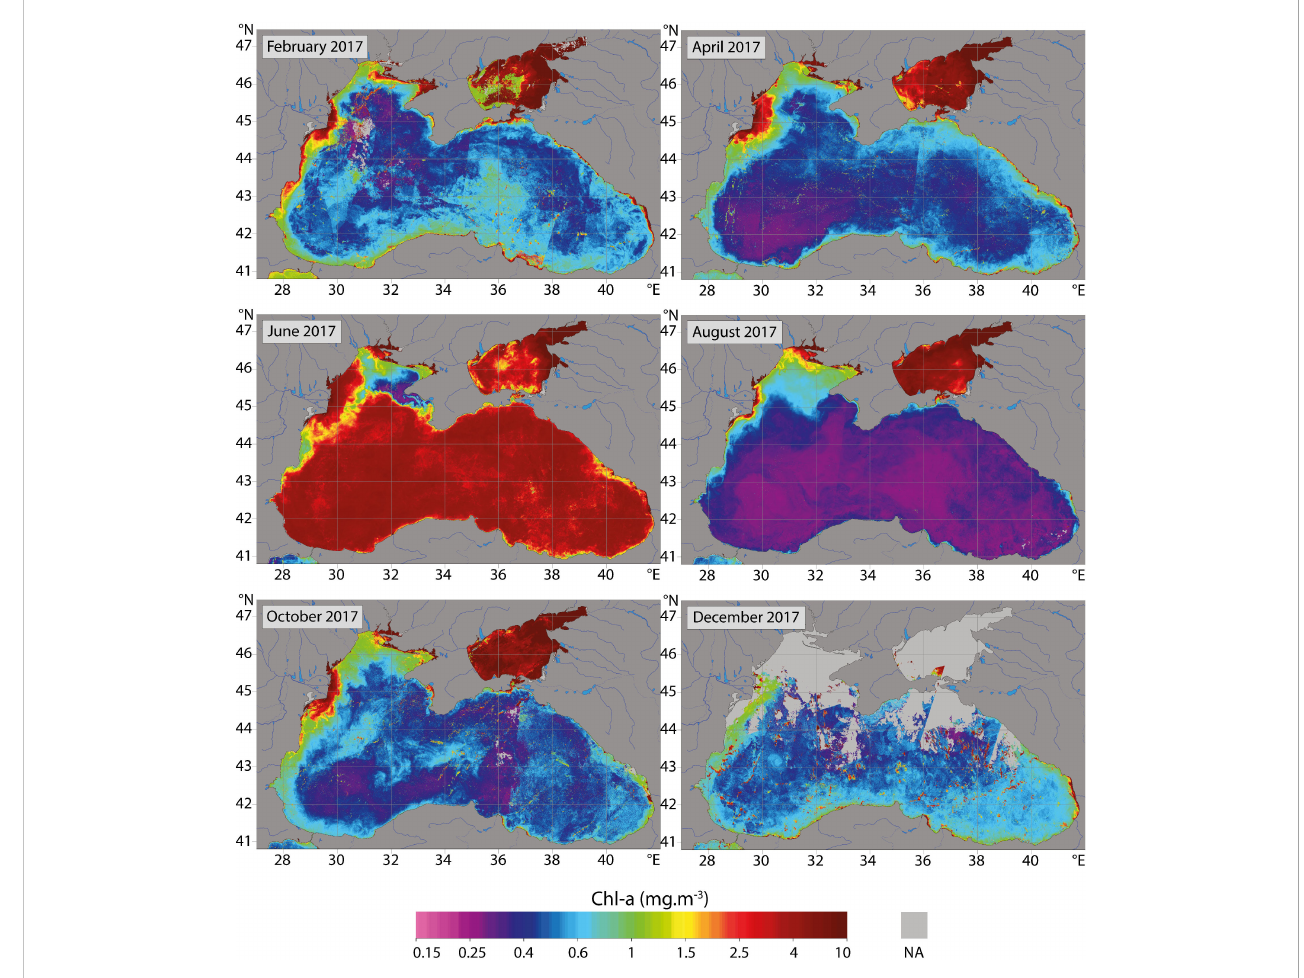
FIGURE 9 EO4SIBS Chl-a concentration maps (monthly composites) during selected months of 2017.